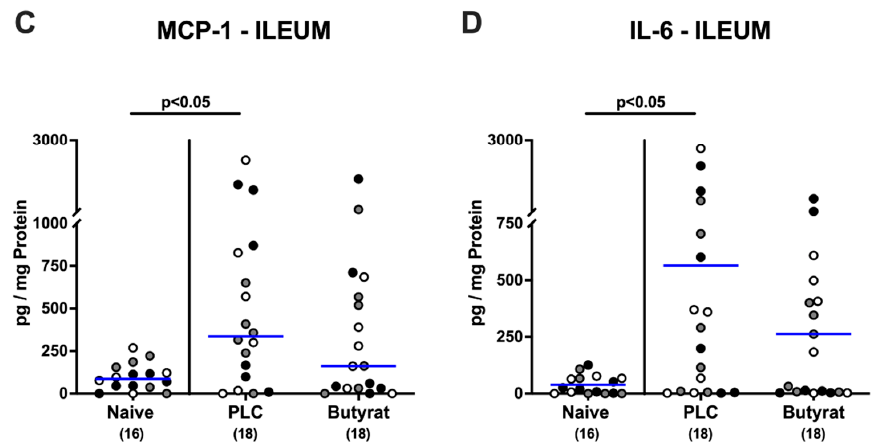
Figure 6. Intestinal pro-inflammatory mediator secretion upon therapeutic butyrate application to C. jejuni -infected mice. Following gut microbiota depletion IL-10 − / − mice were challenged with C. jejuni strain 81–176 by oral gavage on days 0 and 1. Starting from day 2 p.i., the animals were subjected to butyrate (BUT) or placebo (PLC) via the autoclaved tap water ad libitum. Naive mice were uninfected and untreated, and served as control animals. On day 6 p.i., TNF- α secretion was assessed in ex vivo biopsies derived from ( A ) mesenteric lymph nodes (MLN) and ( B ) colon, whereas in the terminal ileum, ( C ) MCP-1 and ( D ) IL-6 concentrations were measured. Differently colored circles indicate data from three individual experiments. Medians (blue bar), significance levels ( p values) evaluated by the ANOVA test with Tukey post-correction or by the Kruskal–Wallis test and Dunn’s post-correction, and total numbers of included animals (parentheses) are shown.